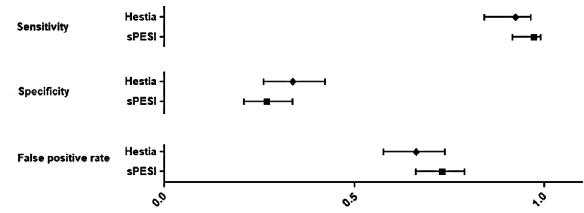
Fig. 2 Hestia Criteria and sPESI score sensitivity, speci fi city and false- positive rate comparisons. sPESI: simpli fi ed Pulmonary Embolism Severity Index.